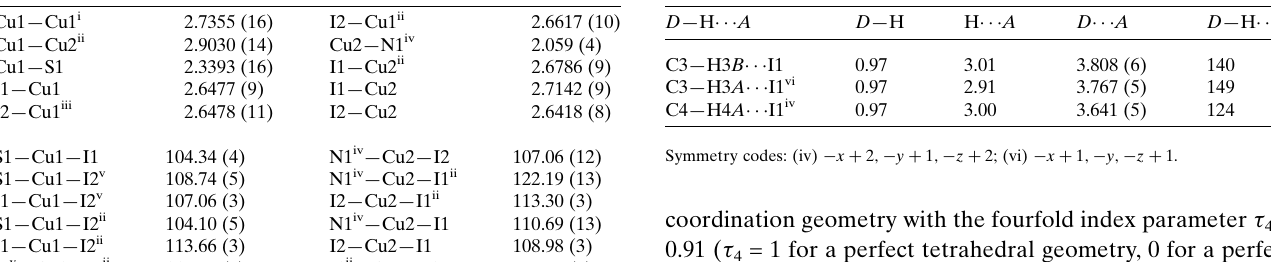
Table 1 Selected geometric parameters (A˚ , (cid:5) ).